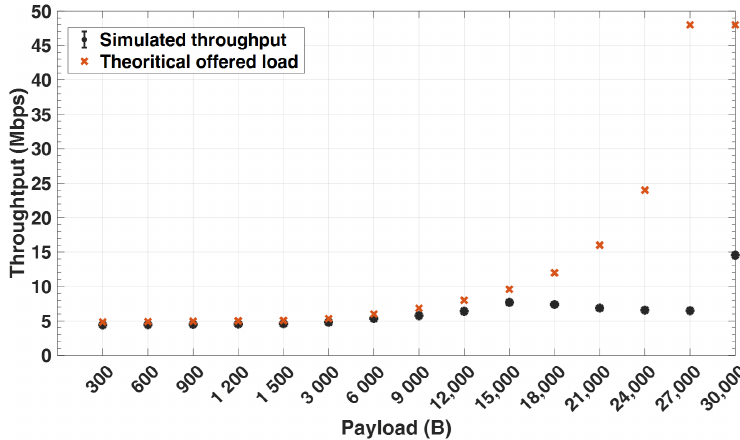
Figure 7. Application level throughput vs. offered